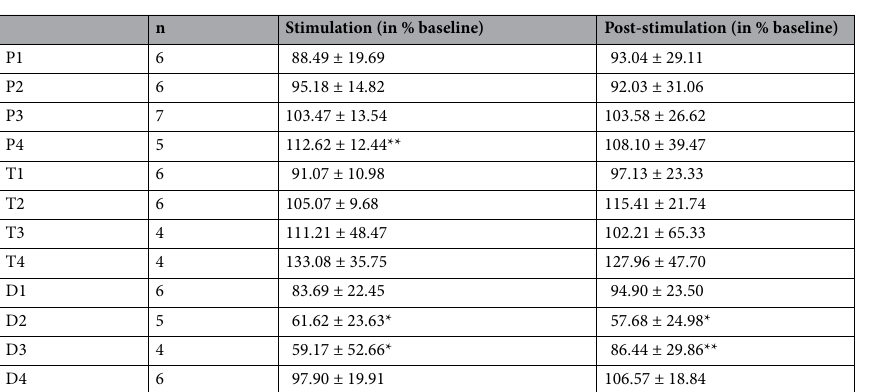
Table 1. Colonic bio-impedance (in % baseline) during direct distal colon stimulation (15 min) and post- direct distal colon stimulation (30 min) in response to direct distal colon stimulation in anesthetized male Yucatan minipigs. Data are mean ± SD of n as indicated for each channel. Significant changes (*P < 0.05 and **P < 0.01) were observed with respect to baseline impedance (100.00 ± 0.00%).